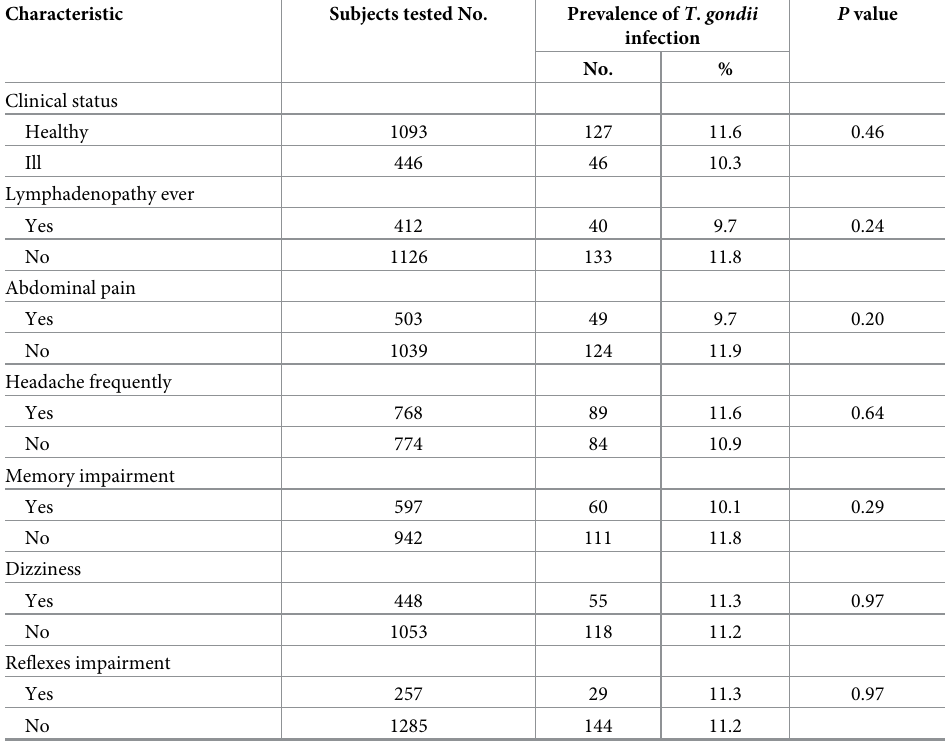
Table 2. Bivariate analysis of clinical data and infection with T . gondii in people with alcohol consumption.